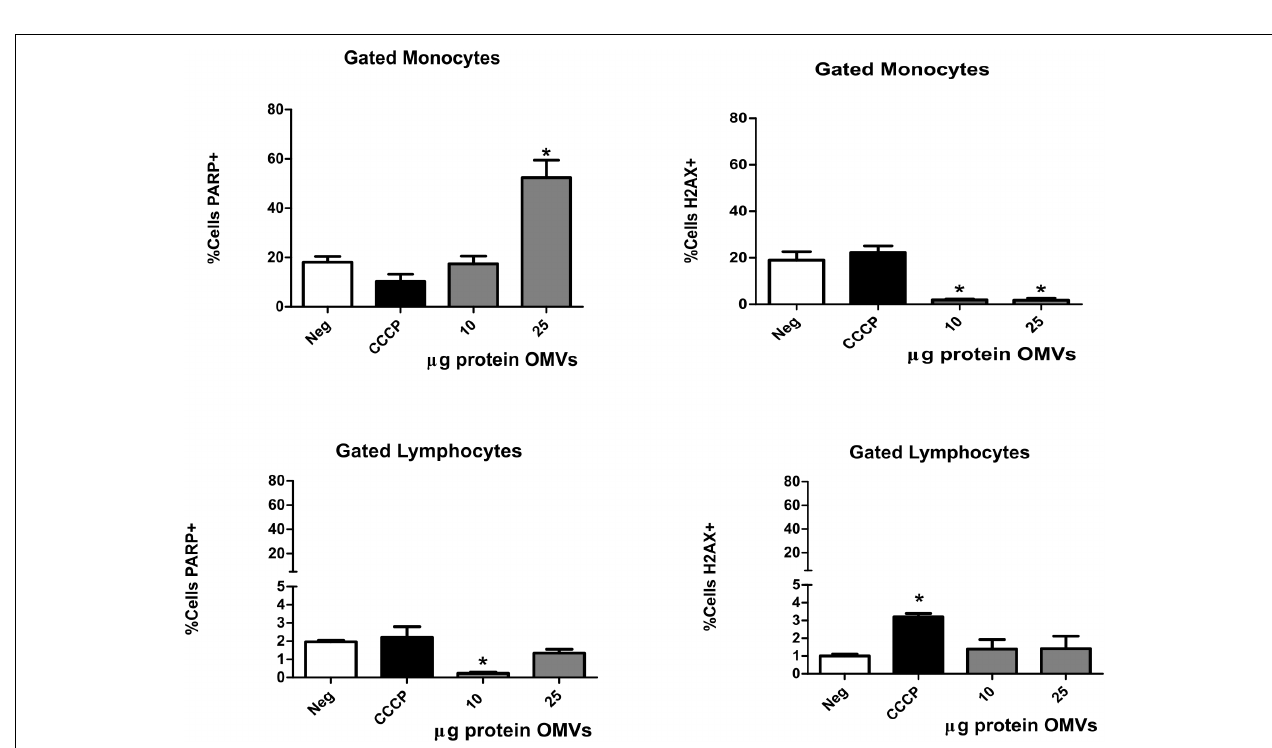
FIGURE 5 | Cytokine quantification from PBMCs stimulated with A. hydrophila ATCC R (cid:13) 7966 TM OMVs. Inflammatory cytokines were determined by CBA cytometric assay at different time points. A. hydrophila OMVs induced high levels of inflammatory cytokines such as IL-8, IL-1 β , IL-6, and TNF α . ∗ P < 0.05, ∗∗ P < 0.01, and ∗∗∗ P < 0.001.